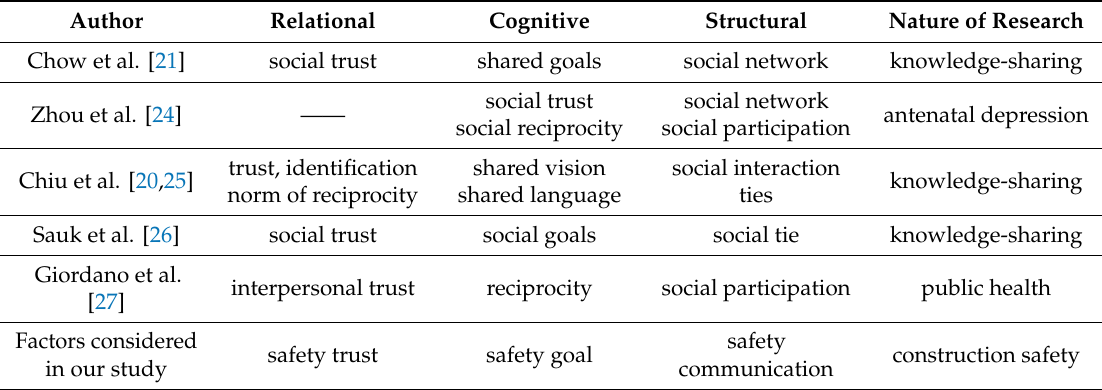
Table 1. Literature of the three dimensions of social